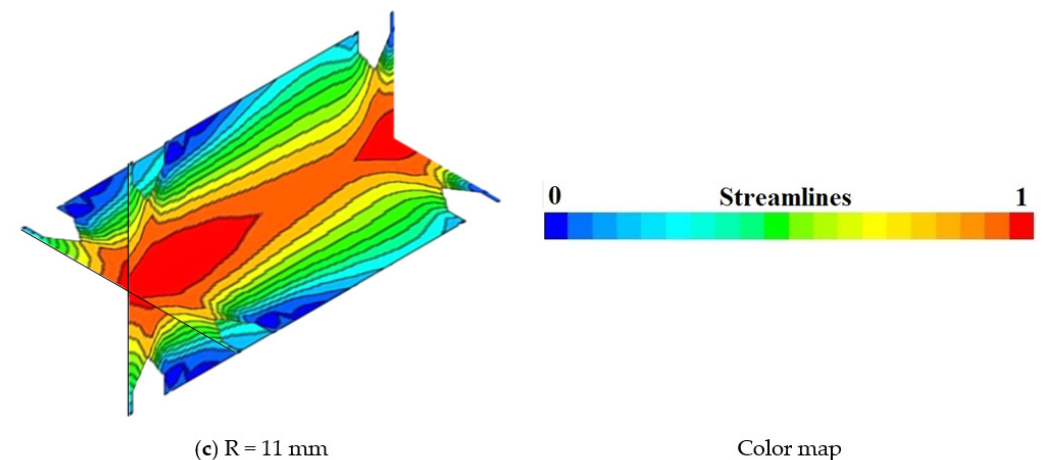
Figure 12. Streamlines for various configurations of Case B with different R parameters at B 2 = 24 mm, Re = 15,000, and ϕ = 0.5%.